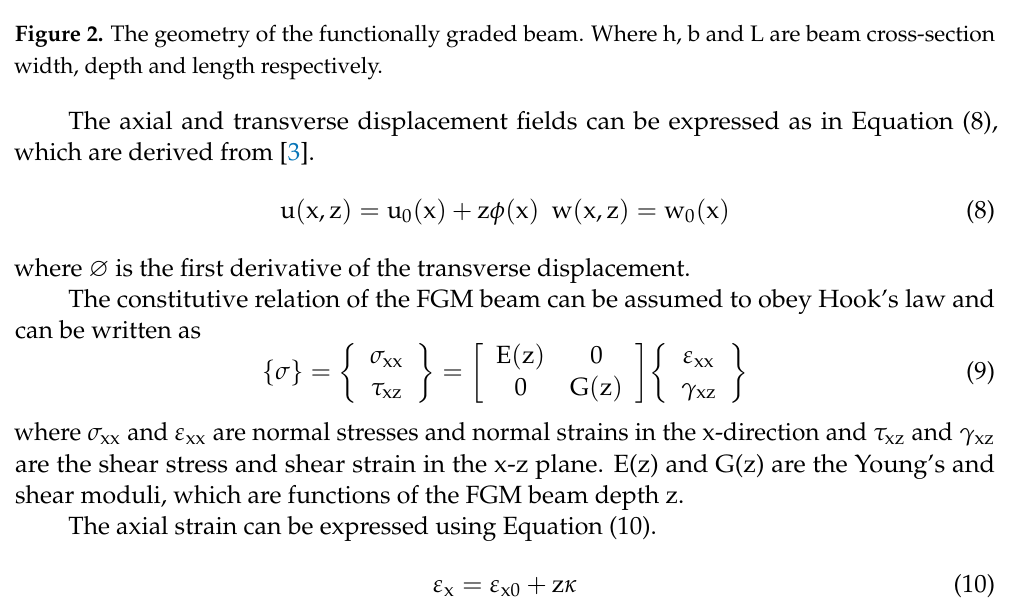
Figure 2. The geometry of the functionally graded beam. Where h, b and L are beam cross-section width, depth and length respectively.